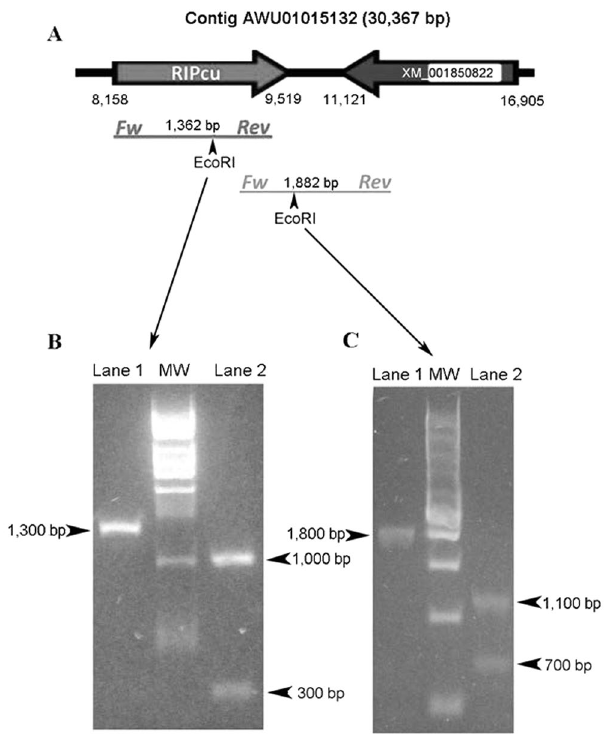
Figure 1. Experimental confirmation of the presence and location of RIP gene in C. quinquefasciatus JHB genome. ( A ) Schematic representation of a fragment of the contig AAWU01015132 depicting the RIP gene (RIPcu) and its closest neighbor gene (XM_001850822). Expected amplicons and relevant EcoRI restriction sites are also presented. The intron of XM_001850822 is represented with a white box. ( B ) RIP ORF was amplified by PCR and the product was analyzed by gel electrophoresis before (lane 1) and after EcoRI treatment (lane 2). ( C ) A fragment of 1,882 bp linking the RIP gene with its neighbor-gene was amplified and electrophoresed before (lane 1) and after EcoRI treatment (lane